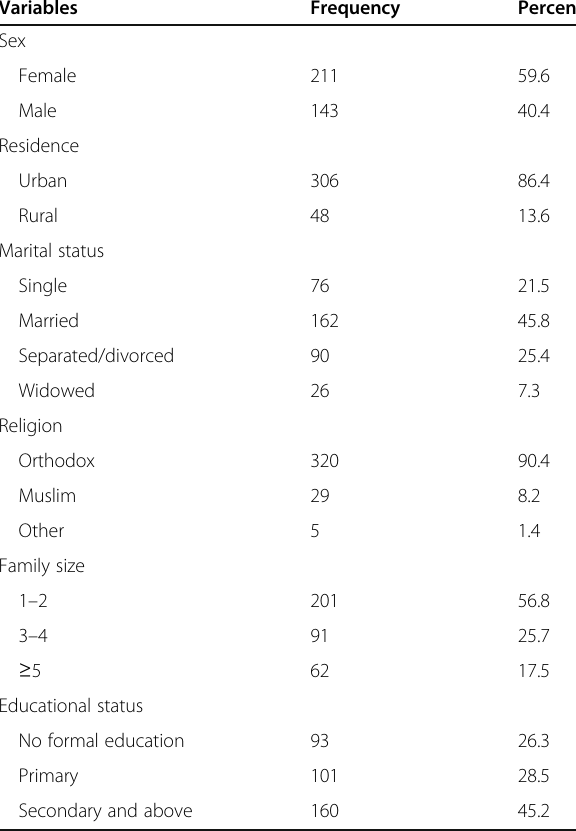
Table 1 Summary results for socio-demographic composition of HIV/AIDS patients treated under ART follow-up (University of Gondar teaching hospital, 2009 – 2015)